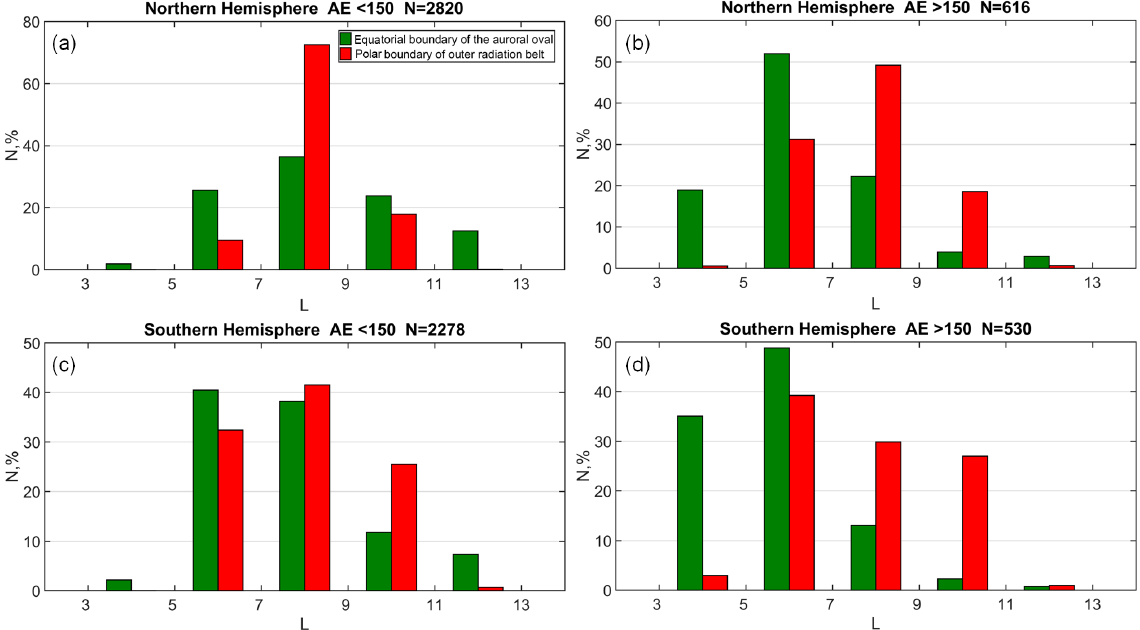
Figure 6. The distributions of the position of the equatorial boundary of the auroral oval (green bins) and the polar ORB boundary (red bins) from L (where L is the McIlwain parameter) for the Northern Hemisphere (a, b) and Southern Hemisphere (c, d) for AE < 150nT (a, c) and AE > 150nT (b, d)